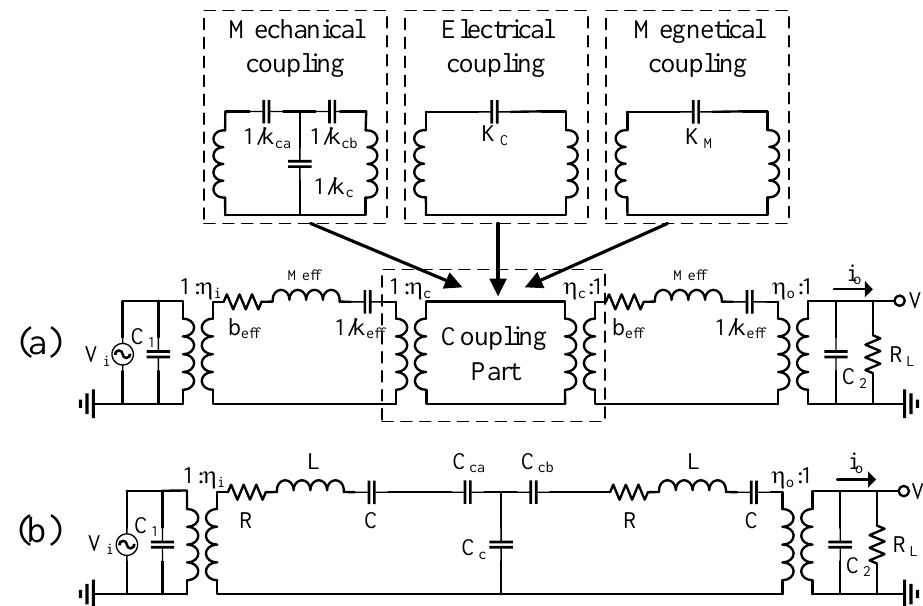
Figure 3. ( a ) Equivalent electrical circuit; ( b ) a simplified version of the